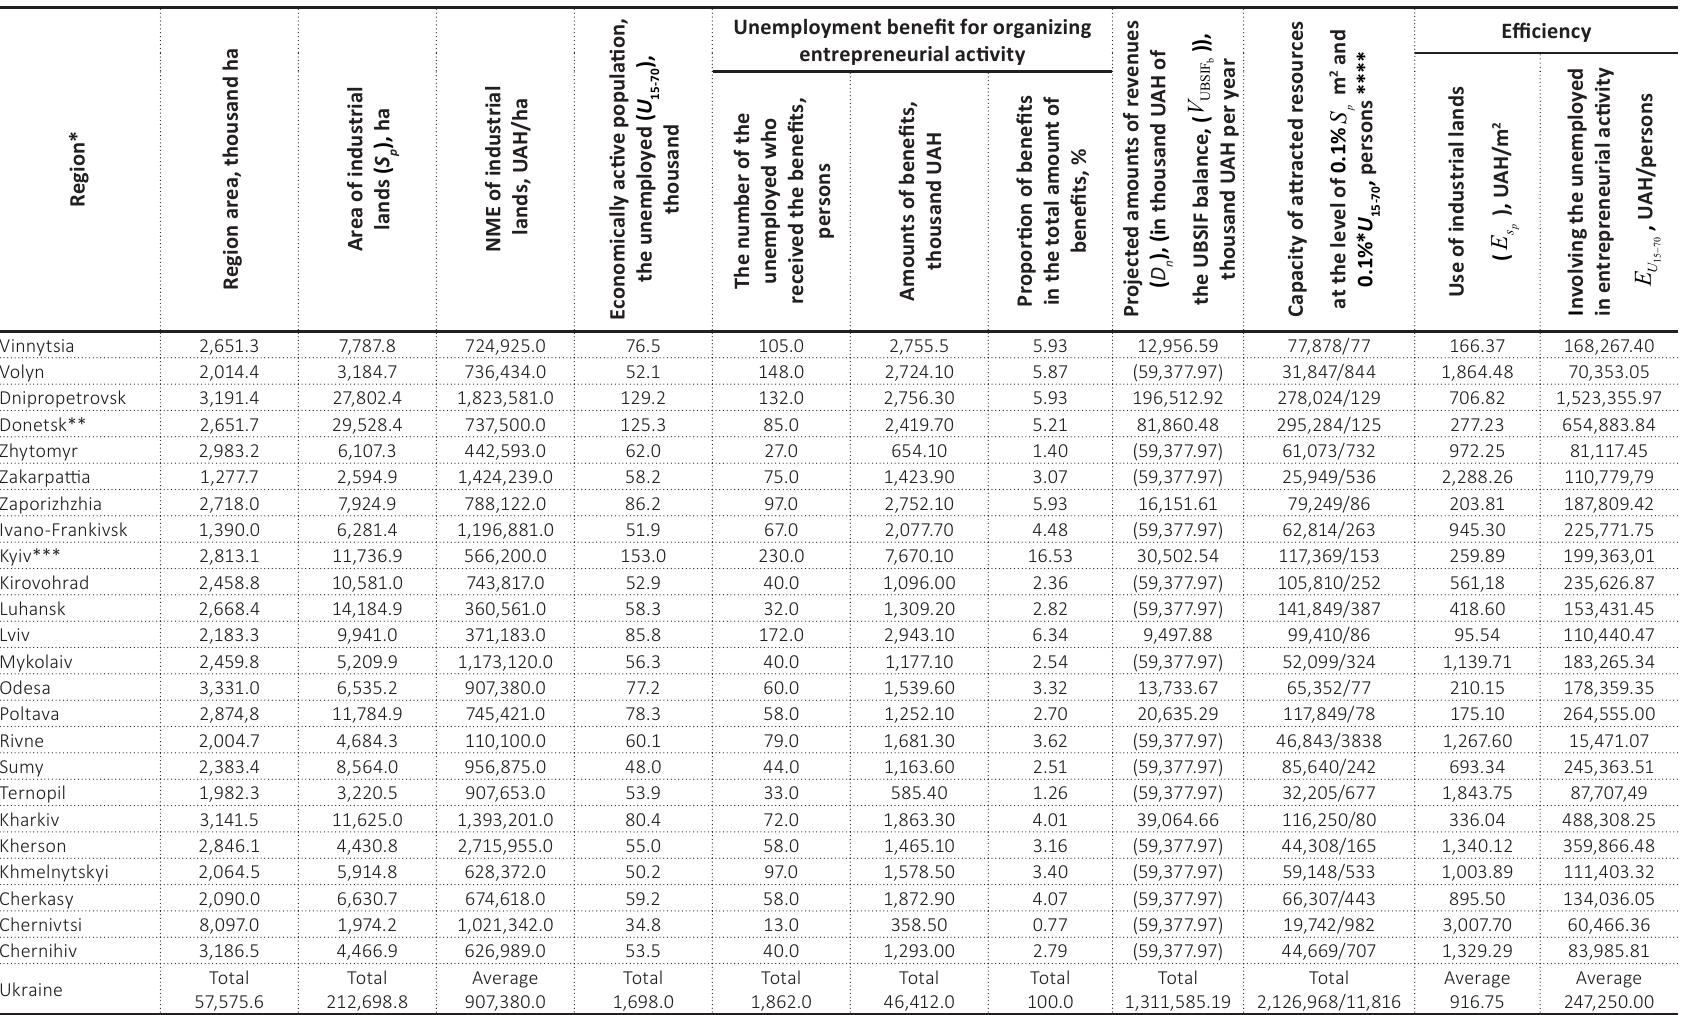
Table 2. Results of calculating the indicators of the efficiency of financial and economic regulation of land relations on the level of each region of